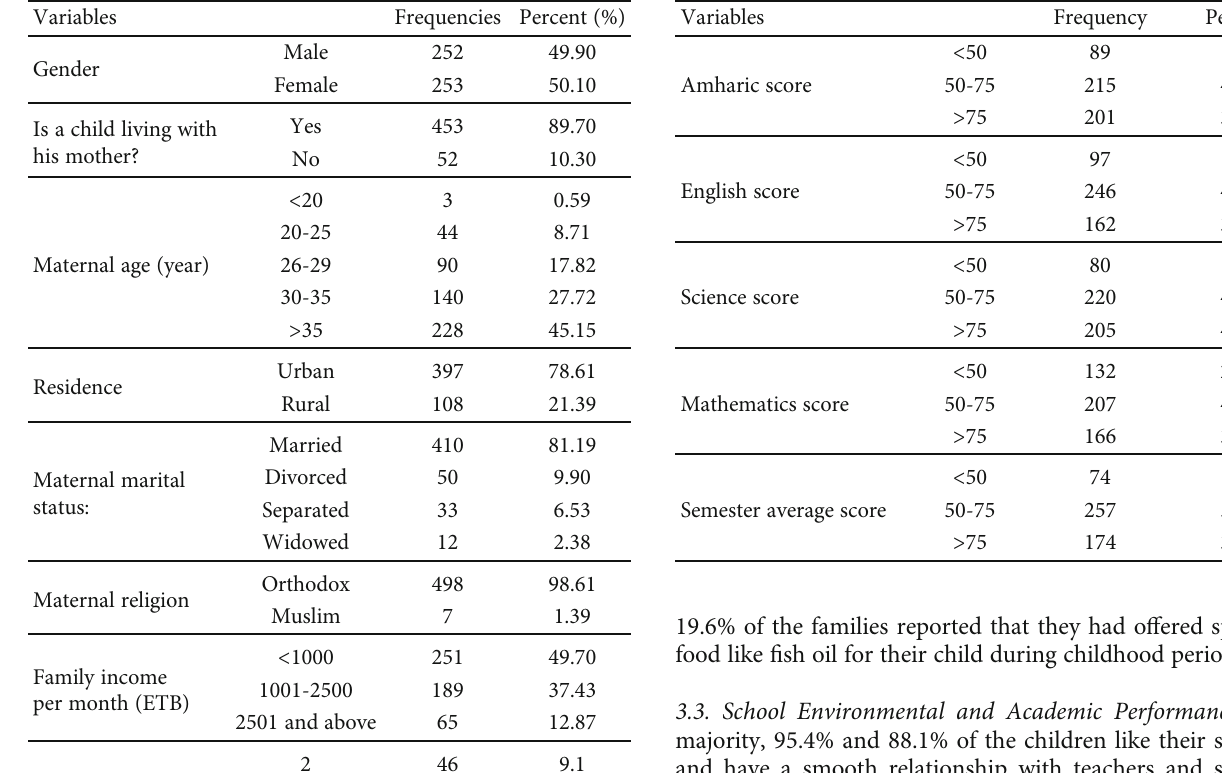
Table 1: Sociodemographic and economic characteristics of the study participants in Lalibela primary schools ( N = 505 ), 2017.